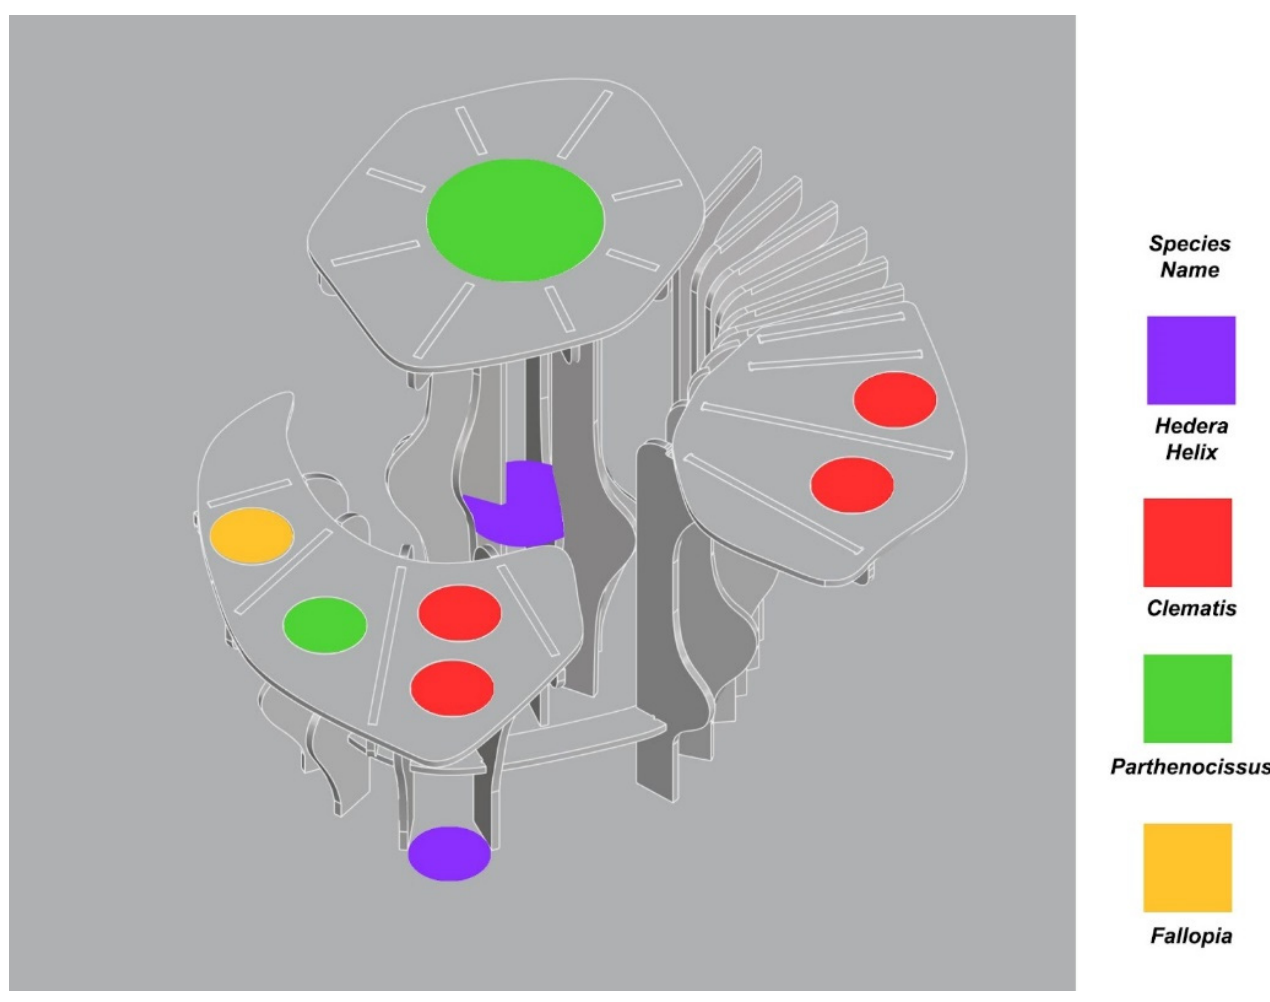
Figure 6. Plant species distribution schematic view.